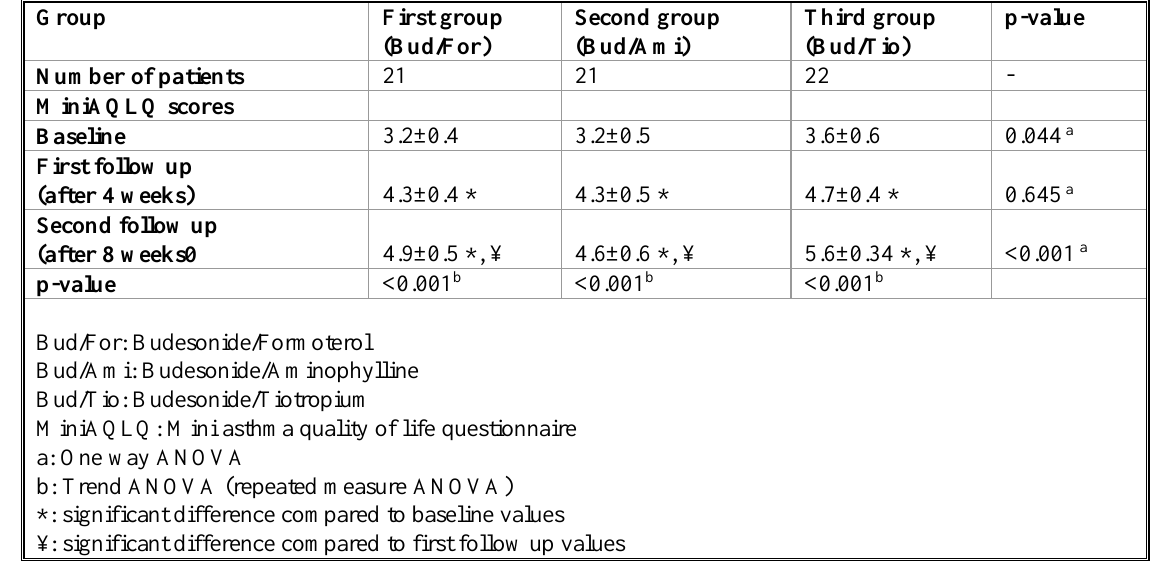
Table 6. Effect of study regimens on patients' MiniAQLQ scores